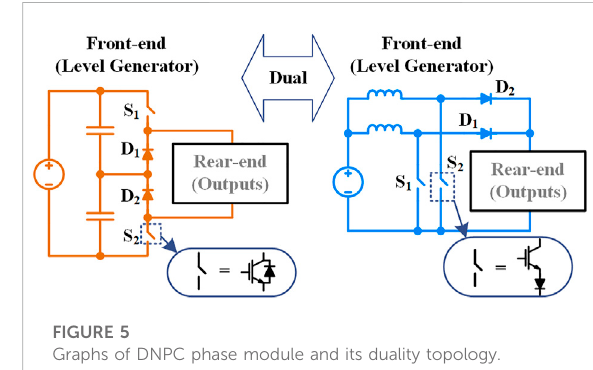
FIGURE 3 Duality between conventional three-phase VSI and CSI.